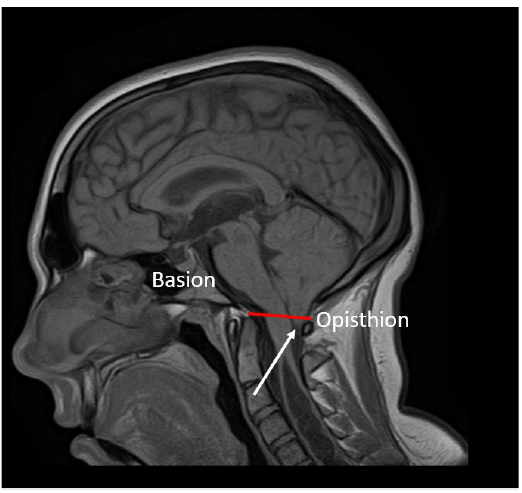
Figure 2. Sagittal T1-weighted MRI scans of the brain: caudal descent of the cerebellar tonsils 6 mm (white arrow) below the McRae line (red line).